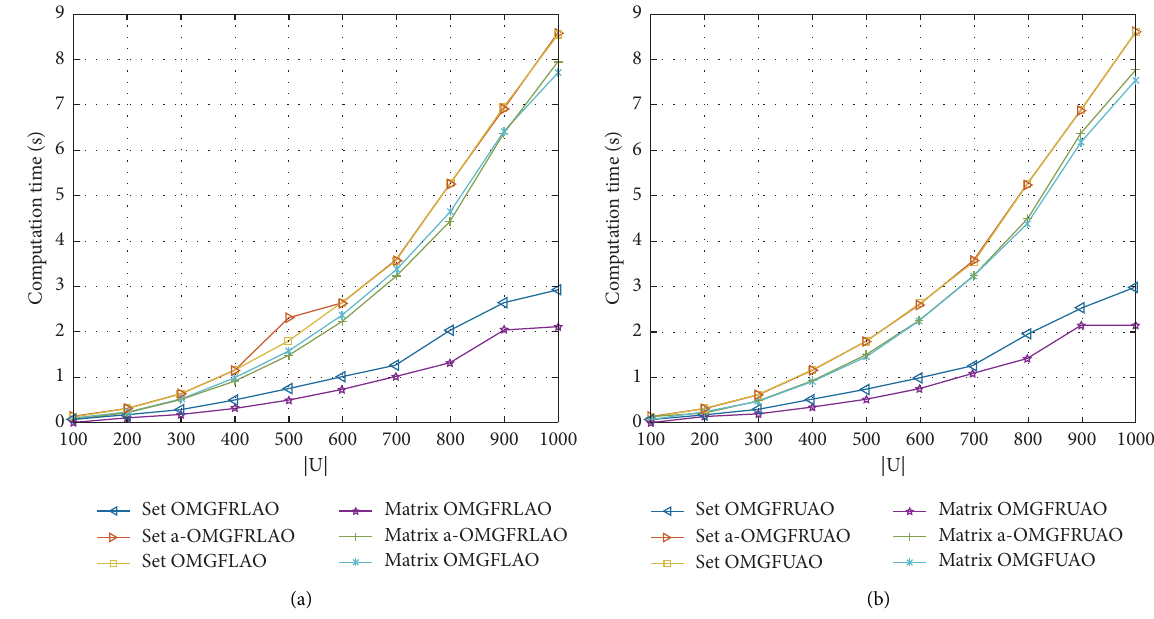
Figure 2: Computational time of matrix methods and set methods with diferent sizes of U ( β � 0 . 5 , | 􏽢 C | � 500 ) . (a) Comparison of matrix methods and set methods of lower approximation operators with diferent sizes of U . (b) Comparison of matrix methods and set methods of upper approximation operators with diferent sizes of U